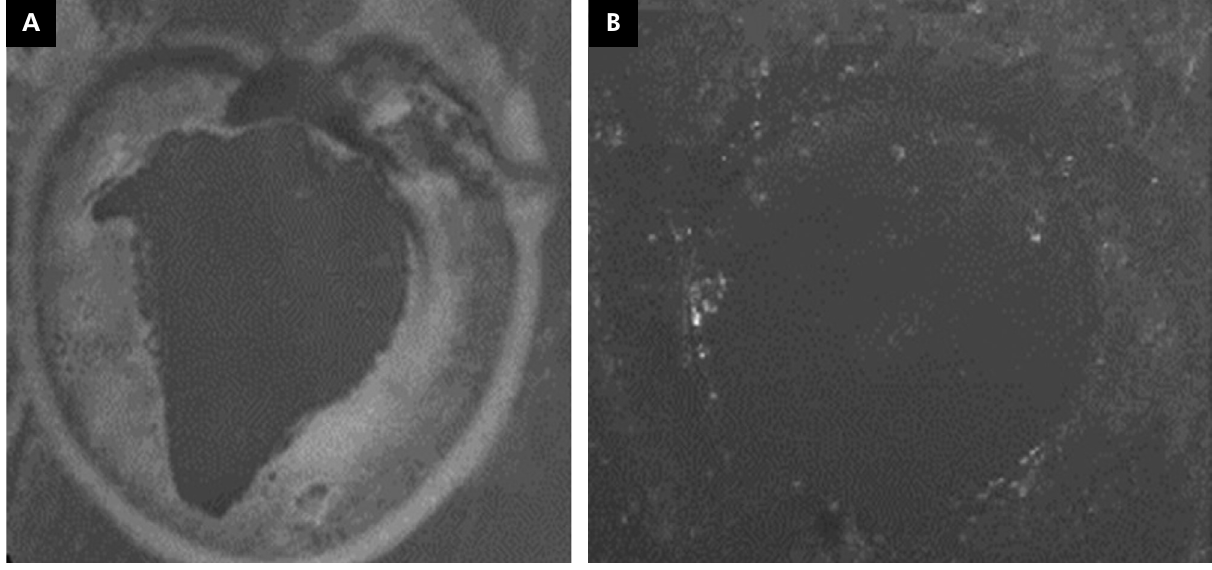
Figure 4. Optical microscopy images: A: Mixed failure mode after microshear bond strength testing. 40× magnification; B: Adhesive failure mode after microshear bond strength testing. 40× magnification.